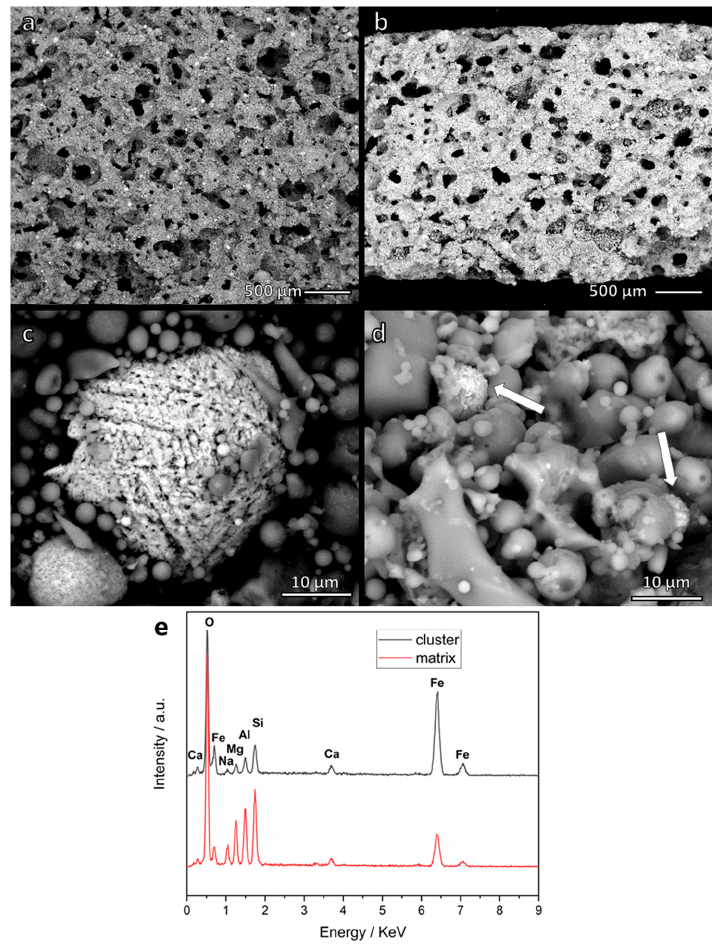
Figure 5. Scanning electron microscopy analysis of samples fired at 800 °C: ( a , c ) 5S; ( b , d ) 7S (iron-rich clusters marked by arrows); ( e ) analysis of Fe-rich cluster and matrix in 5S sample.